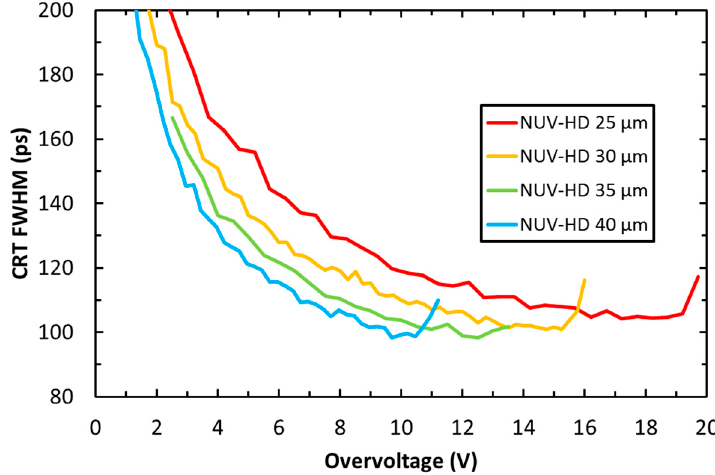
Figure 15. CRT as a function of the OV for NUV-HD LowCT SiPMs having different cell sizes.